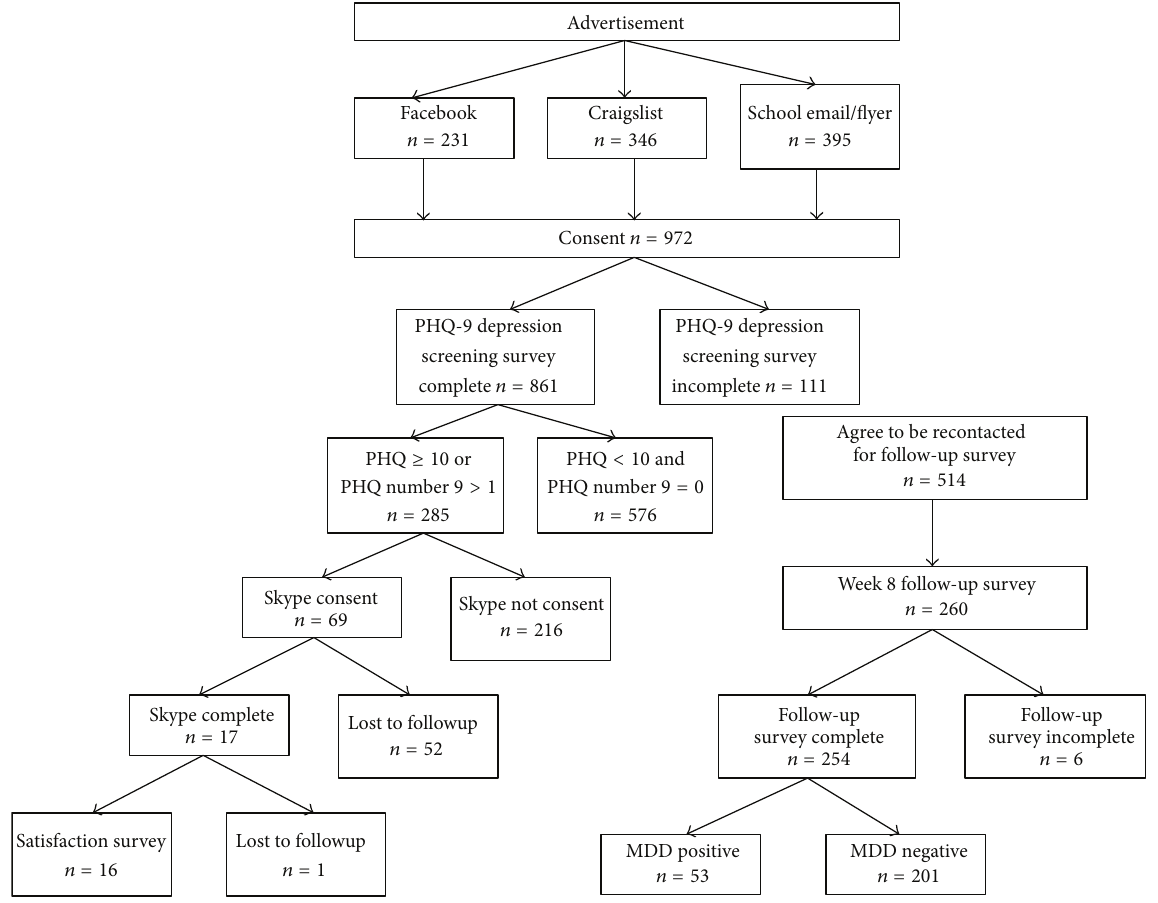
Figure 1: Subject participation and study